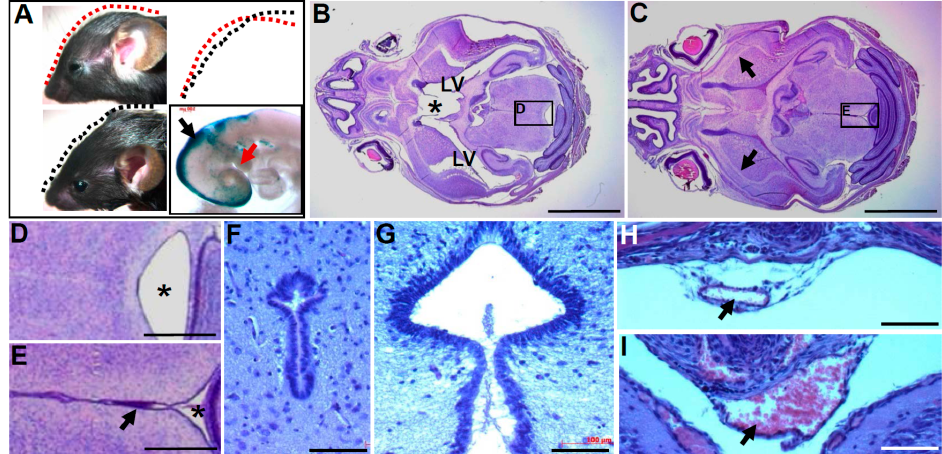
Figure 6. Pax3 flox/flox /Pax7 − Cre conditional knockout mice exhibit congenital hydrocephalus,